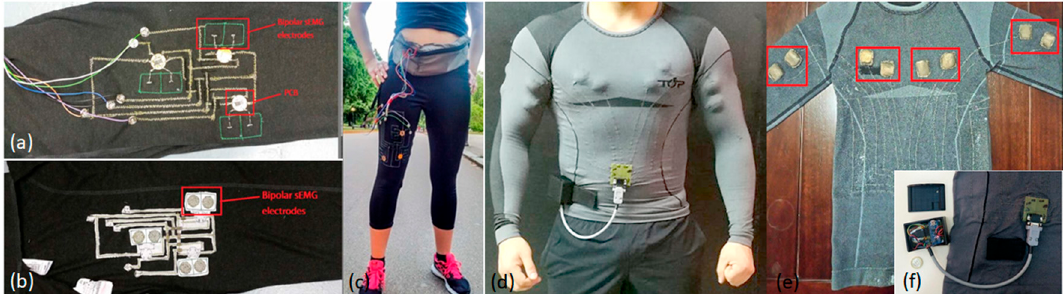
Figure 6. Wearable electromyography (EMG) acquisition garments: running leggings and a sports shirt. Electrode placement in the ( a ) exterior; and ( b ) interior of leggings; ( c ) actual view of leggings when worn by a subject [153]; ( d ) shirt as worn by a subject; ( e ) location of electrodes on the shirt; ( f ) close-up view of the acquisition unit attached to the shirt [115].